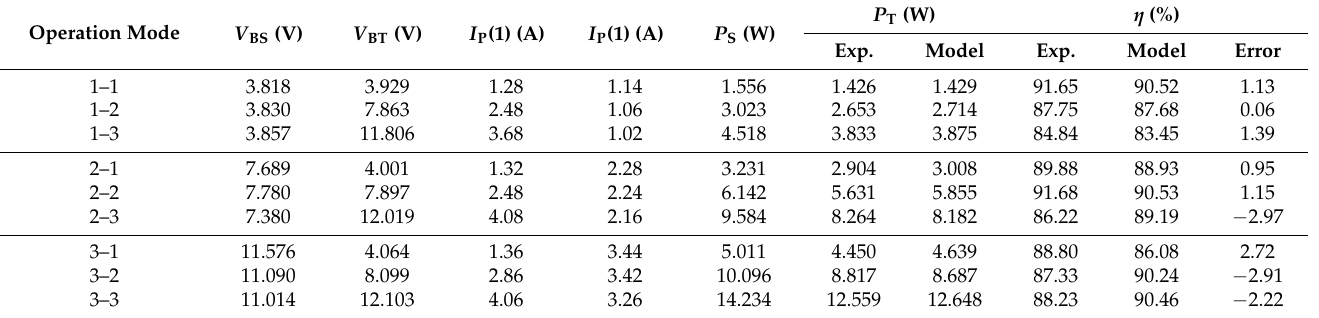
Table 3. Experimental data of the proposed equalizer in different operation